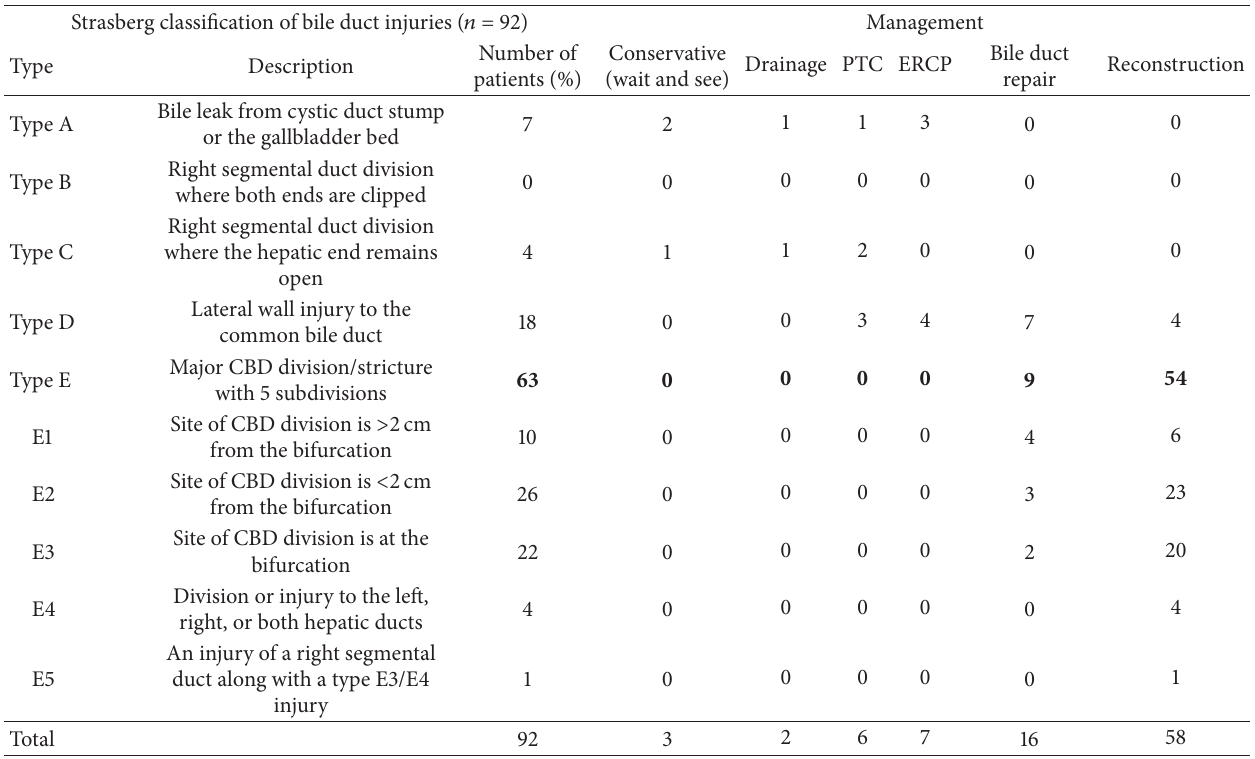
Table 2: Definite management of BDI according to their type.